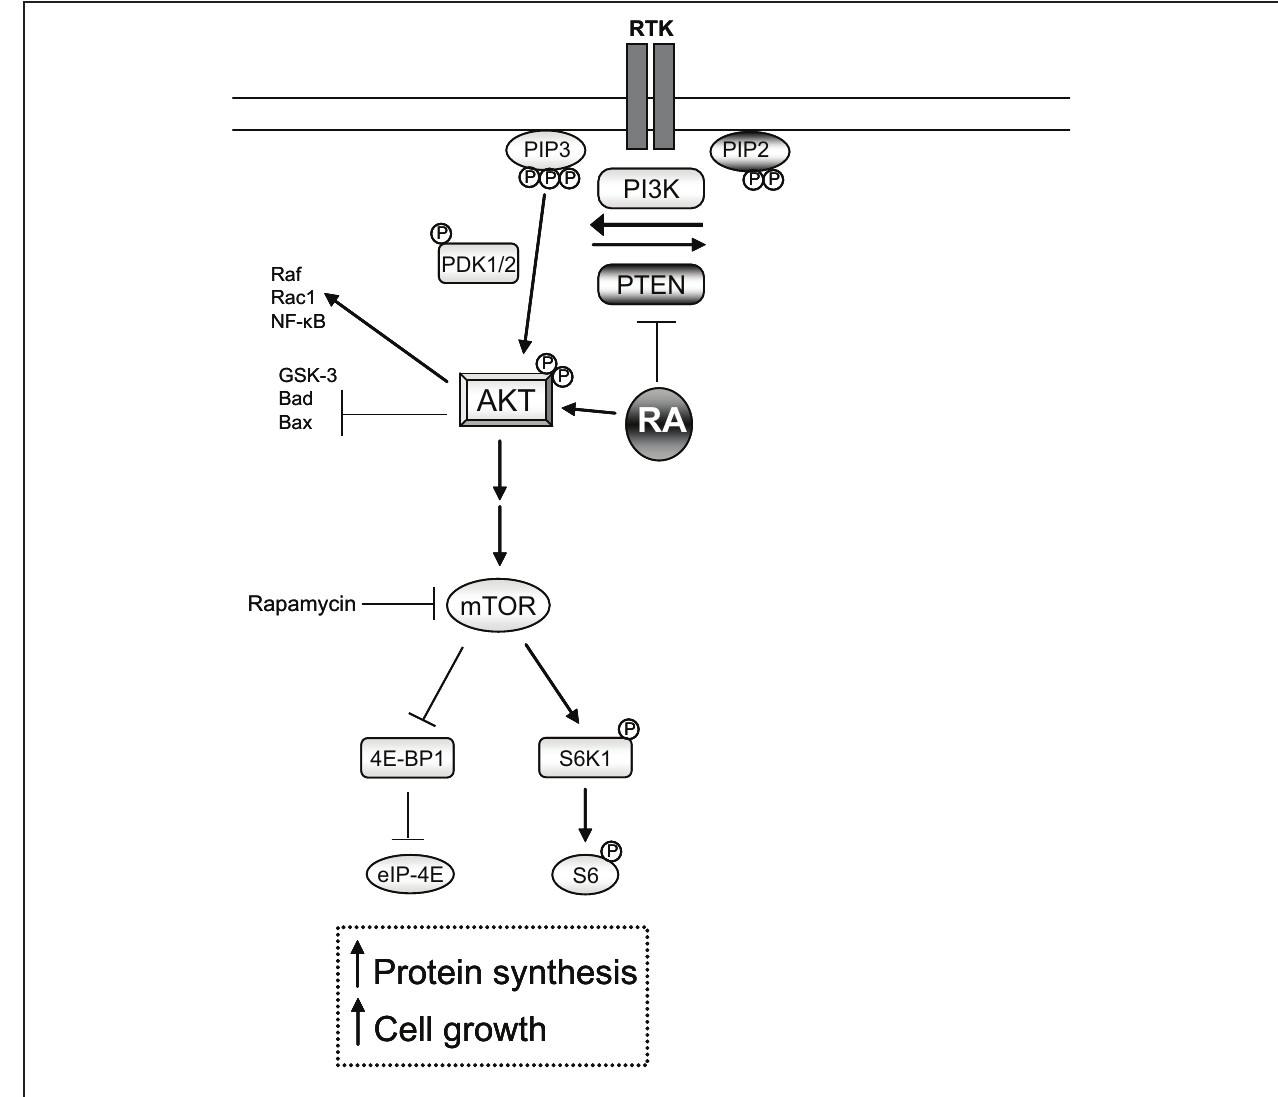
FIGURE 2 | RA-dependent non-transcriptional involvement in neurite outgrowth. Inhibition of PTEN leads to increased levels of PIP3 via PI3K. This in turn activates AKT by phosphorylation. Active pAKT has many functions such as the inhibition of GSK-3, Bad, or Bax, conversely it can activate Raf, RacI, and NF- κ B. Recently in axonal regeneration it has been shown that active pAKT leads to the activation of the mTOR pathway (which can be inhibited via rapamycin). This leads to increased